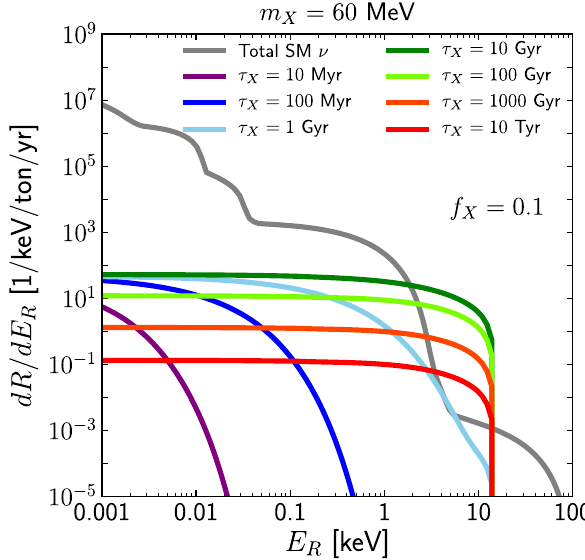
Fig. 2 Energy differential recoil rate on xenon induced by standard fluxes (gray line) and induced by DR originating from a progenitor with m X = 60MeV and various lifetimes as labeled (colored